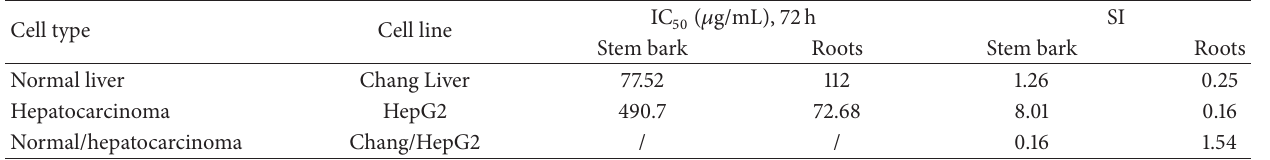
Table 4: Cytotoxicity of the ethanolic extracts of R. vomitoria stem bark and